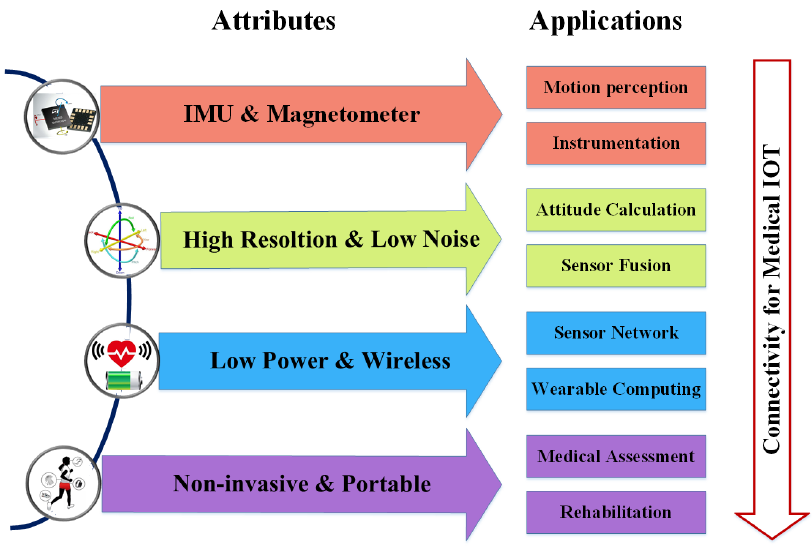
Figure 12. Medical Internet of Things and gait